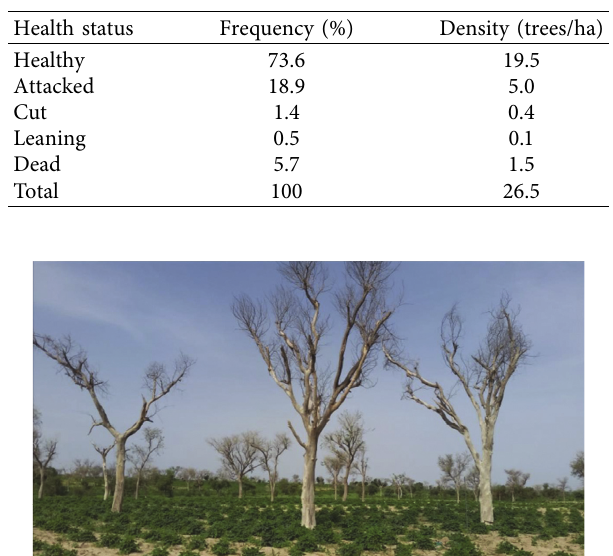
Figure 1: Distribution of health status of F. albida trees according to DBH. Table 1: Distribution of the health status of F. albida trees.